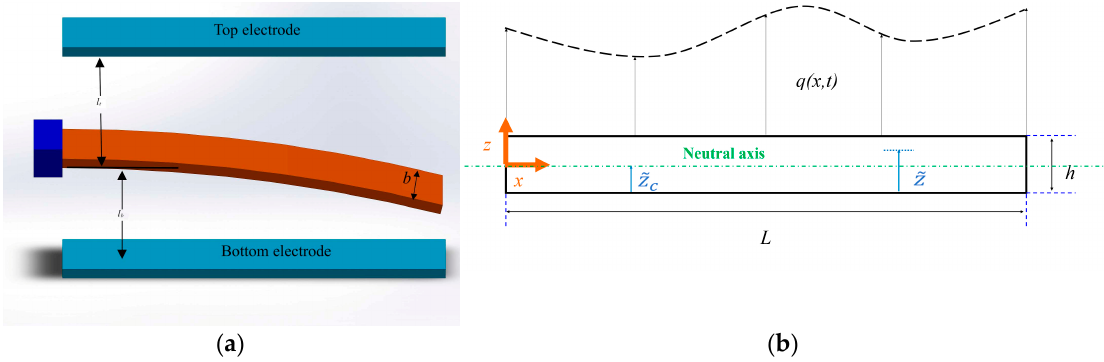
Figure 1. Functionally graded material (FGM) micro-switch model and the electrodes configuration: ( a ) clamped-free boundary condition and ( b ) diagram of the micro-switch.